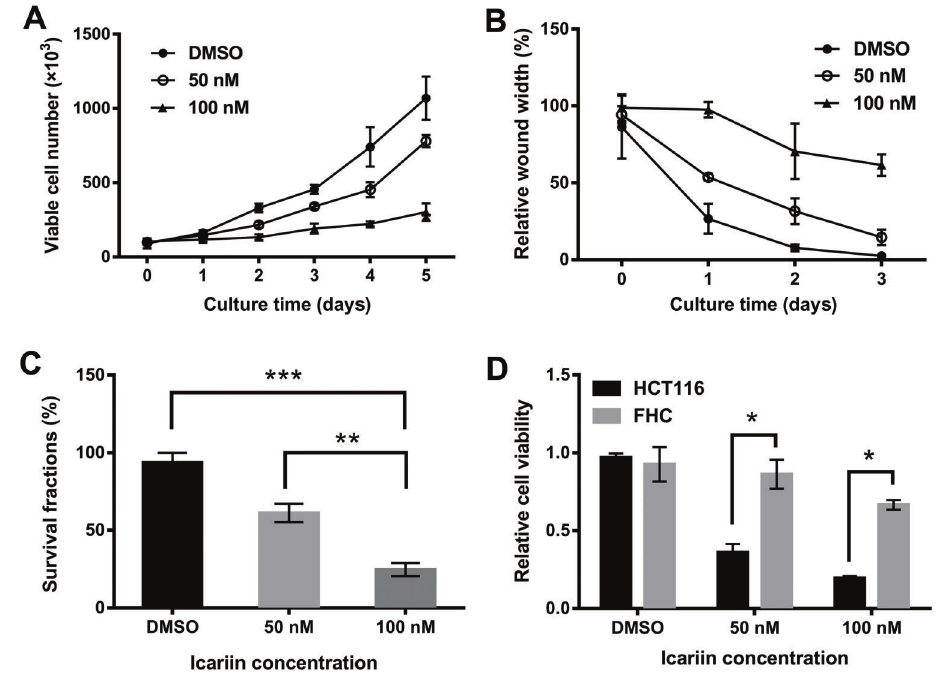
Figure 1. Growth and migration of HCT116 cells were suppressed by icariin and the inhibitory effect was both time- and dose- dependent. A , Viability and ( B ) migration of HCT116 cells were assessed by the trypan blue staining method and wound healing assay, after treatment with different dosages of icariin for different times. C , Colony formation was assessed for viability analysis. D , Viability of HCT116 cells and FHC (normal) cells after icariin treatment were compared according to CCK-8 assay. Assays were performed in triplicate. Data are reported as means ± SD. *P o 0.05, **P o 0.01, ***P o 0.001